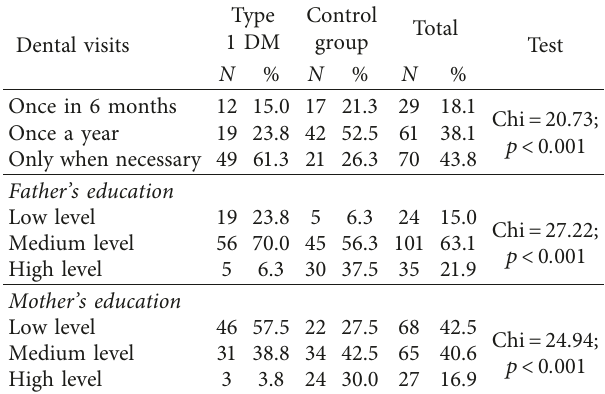
Table 5: Dental visits and parents’ education between